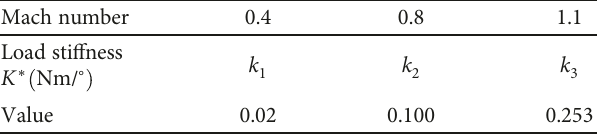
Table 1: Load sti ff ness for fi xed Mach